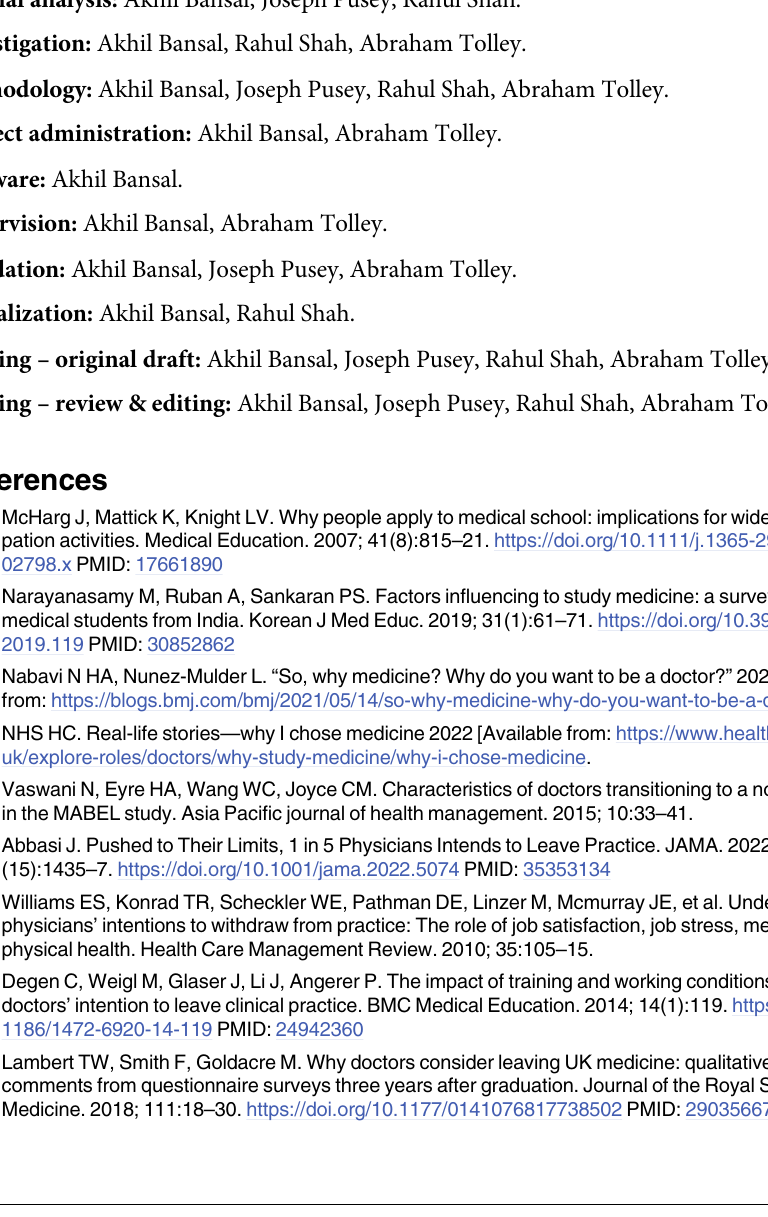
S1 Table. Full anonymised dataset. Spreadsheet contains qualitative and quantitative survey